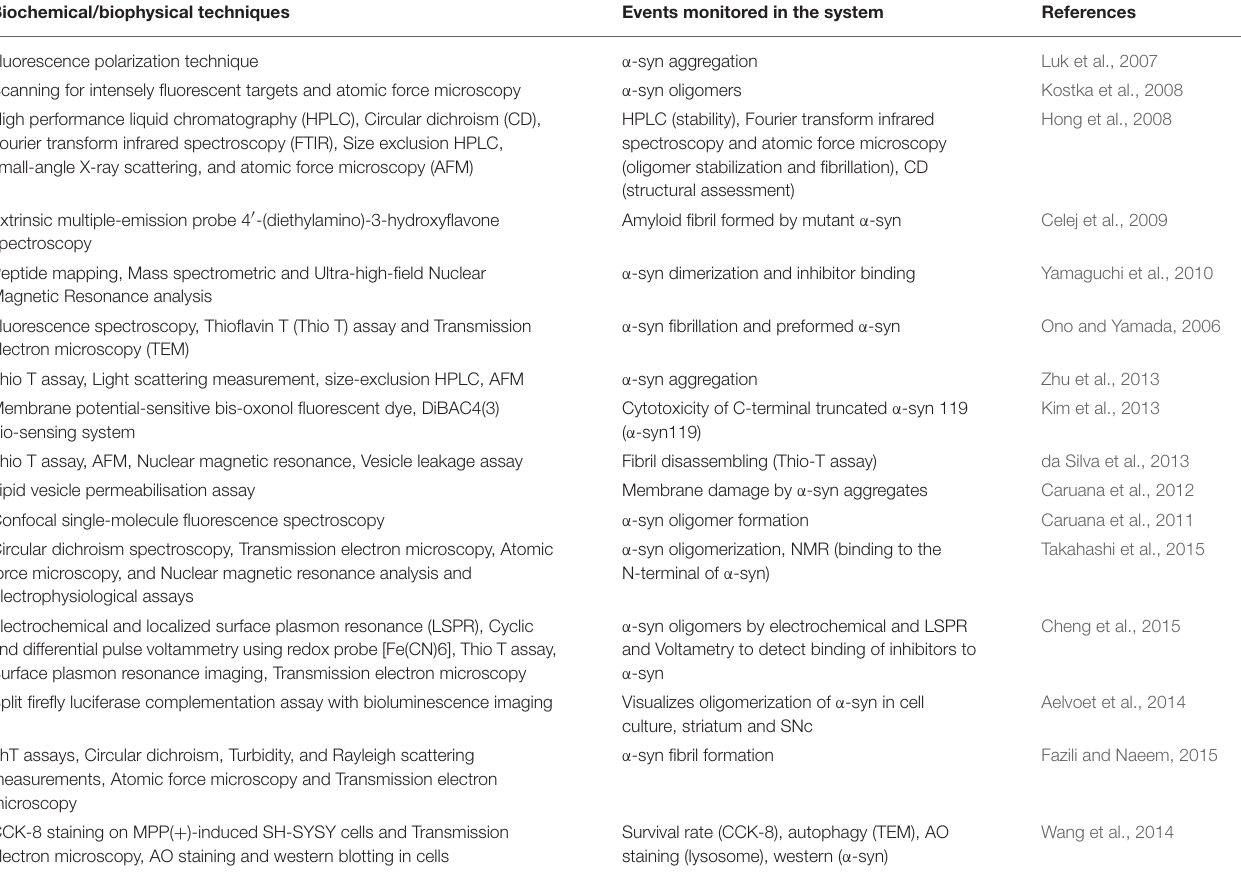
TABLE 6 | The bioanalytical techniques employed to determine α -synuclein oligomerization, fibrillation, and cytotoxicity.